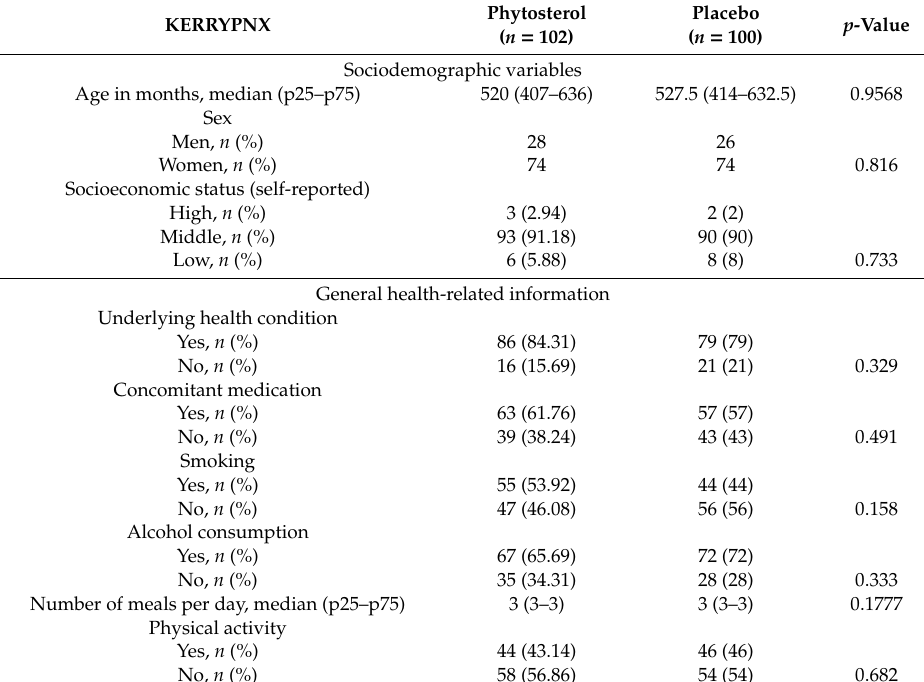
Table 2. Baseline participants’ characteristics by the group.